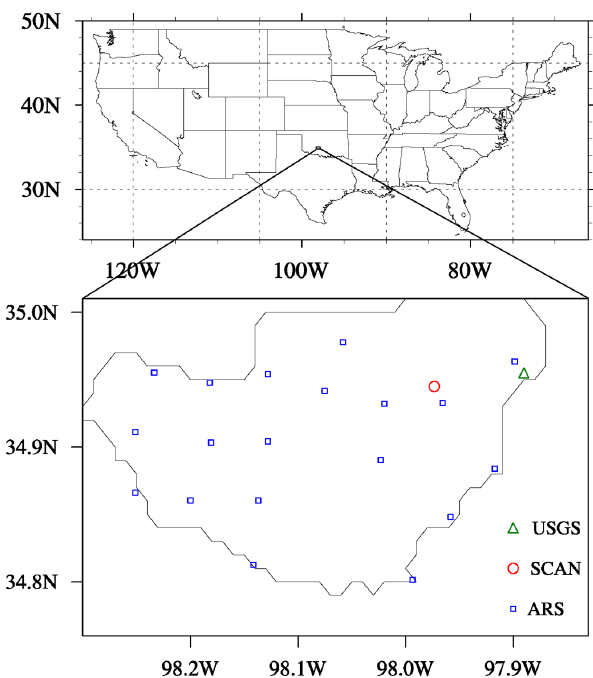
Fig. 1. The Little Washita watershed and locations of ARS, SCAN and USGS